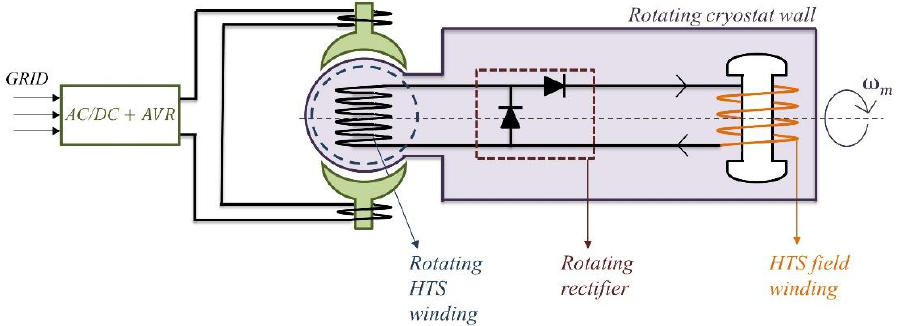
Figure 8. Contactless supply system of the rotor HTS field winding of the EcoSwing turbine based on the cold rectifier flux pump. The electromagnets at ambient temperature are fed by the AC/DC converter and the automatic voltage regulator (AVR), which are in turn connected to the grid.